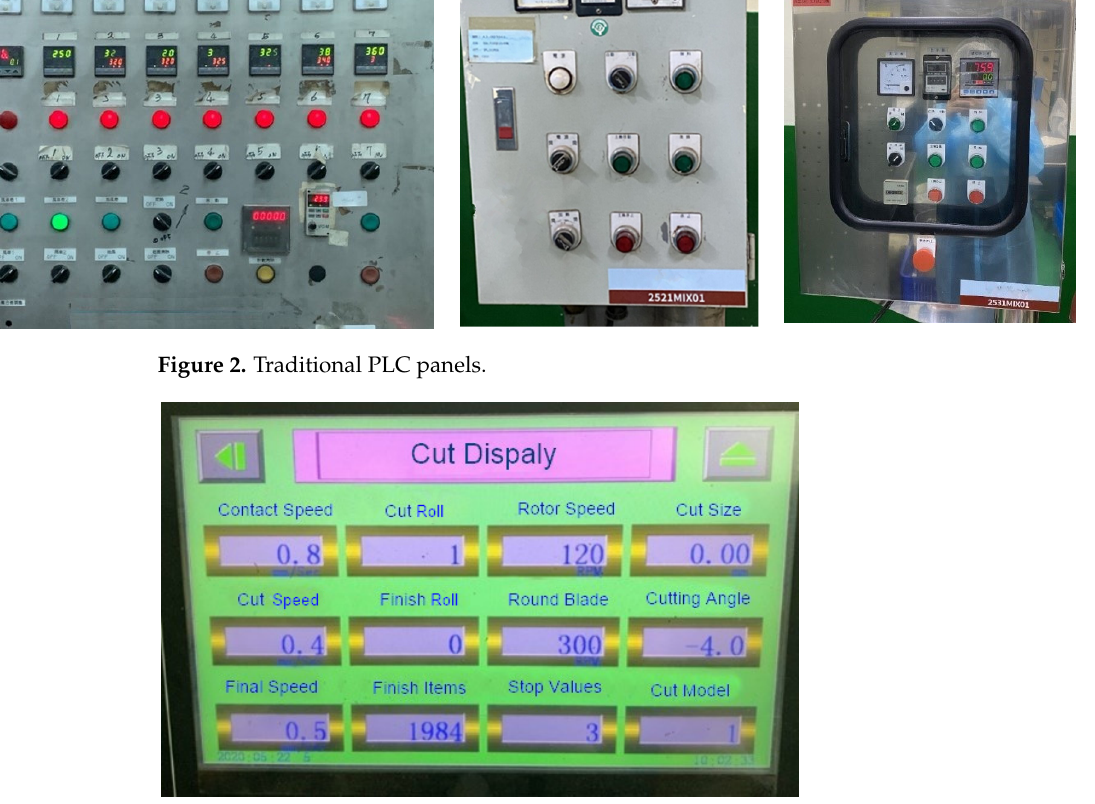
Figure 3. LCD screen of PLC panels.